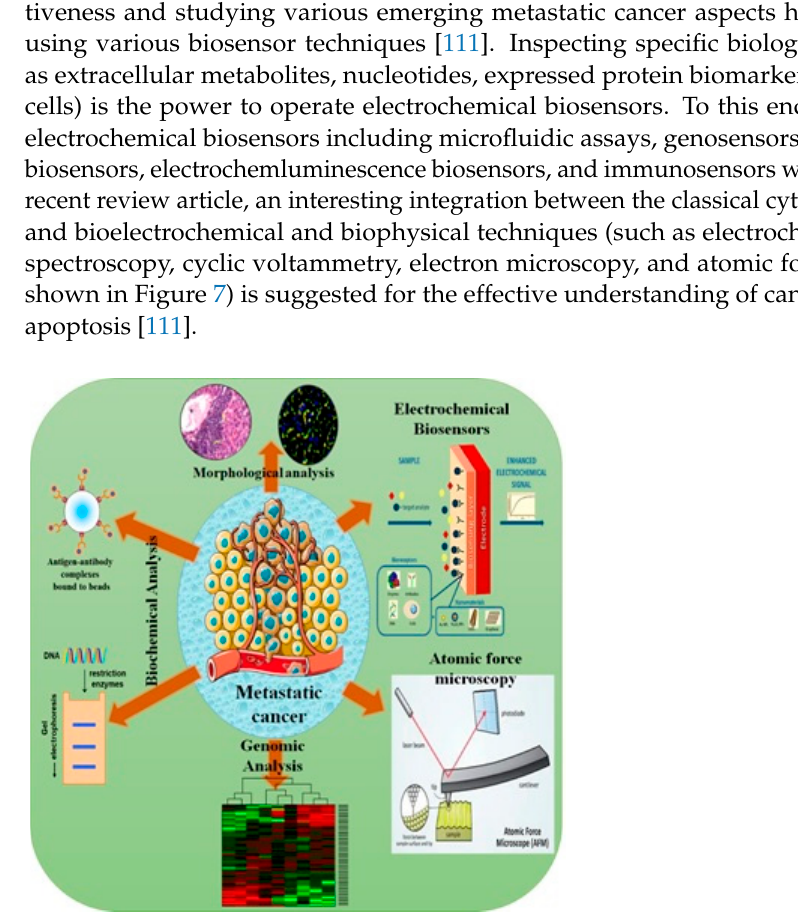
Figure 7. A new vision for cancer investigation through combinatorial biochemical and biophysical